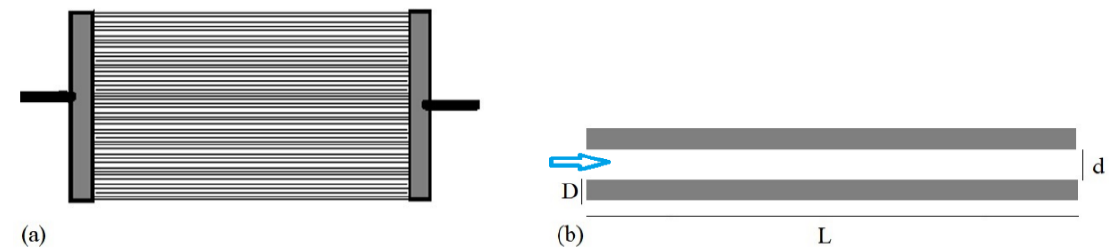
Figure 1. ( a ) The bunch of elastocaloric wires. ( b ) A zoom on two wires. The blue arrow represents a velocity whose value is object of the investigation.